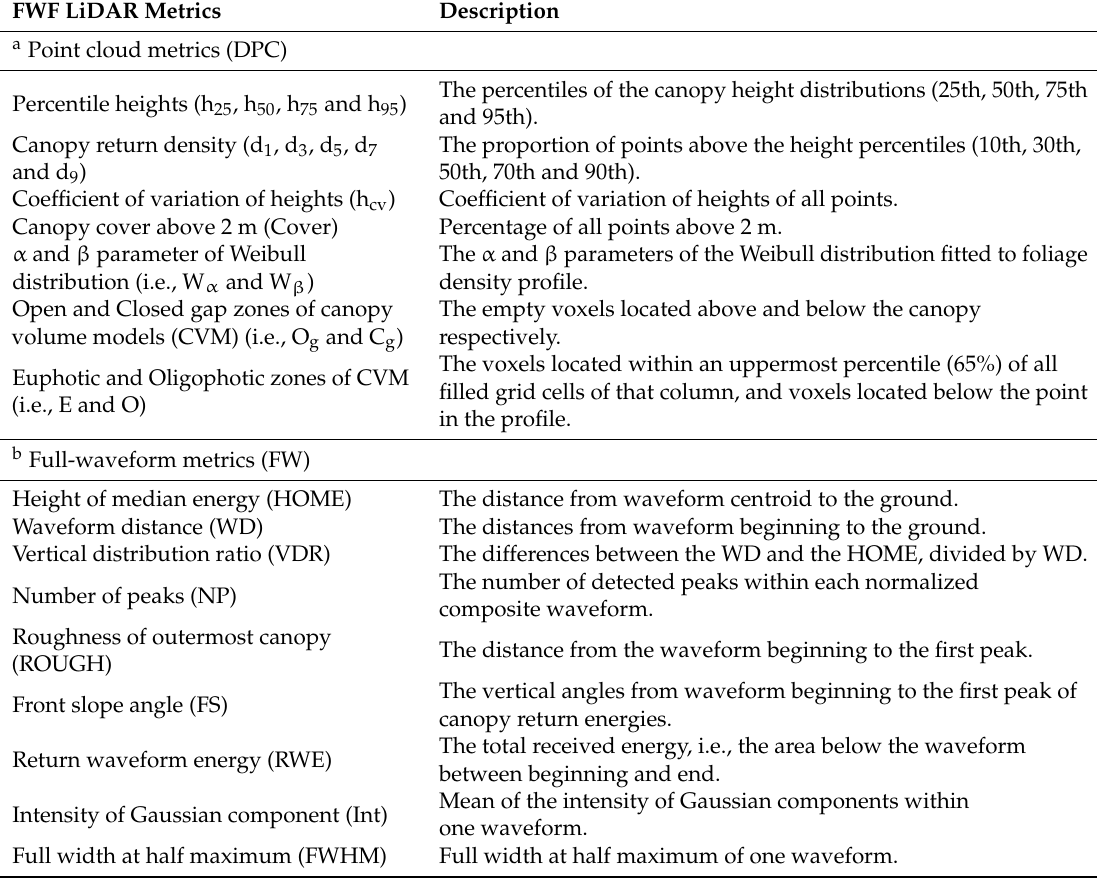
Table 3. The summary of the FWF LiDAR metrics (i.e., DPC and FW) extracted from FWF LiDAR data (the code and description of each metric are